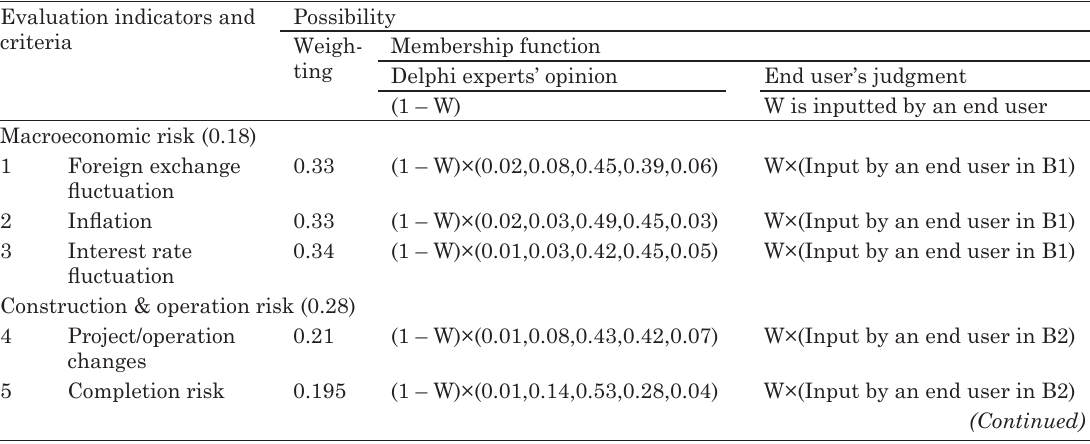
table 5. the weighting and membership function for possibility of each risk indicator and risk criterion evaluation indicators and criteria